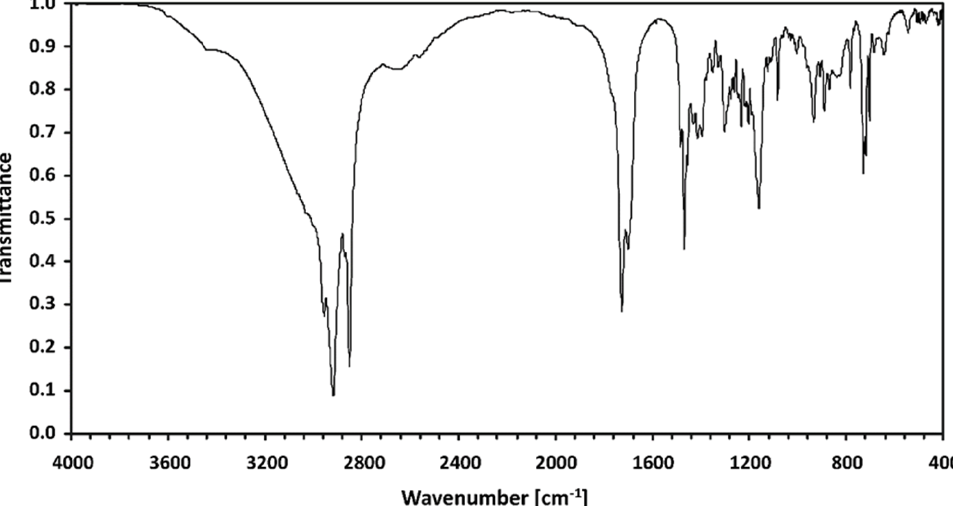
Figure 3. Influence of coating DES-based sorbent prepared with DES-1 (orange), DES-2 (green), DES-3 (burgundy) and DES-4 (violet) each in molar ratios 1:1, 1:2, 1:3 and desorption solvent (ACN/H 2 O in different volume ratios) on analytical signals of formaldehyde derivative obtained by the DES-TF-SPME/HPLC-UV-Vis method. The measurements were performed using 200 mL samples containing 125 ng mL − 1 of formaldehyde derivative. Conditions: extraction time 30 min with the addition of 0.05 mg L − 1 NaCl and desorption for 12 min ( n = 4).